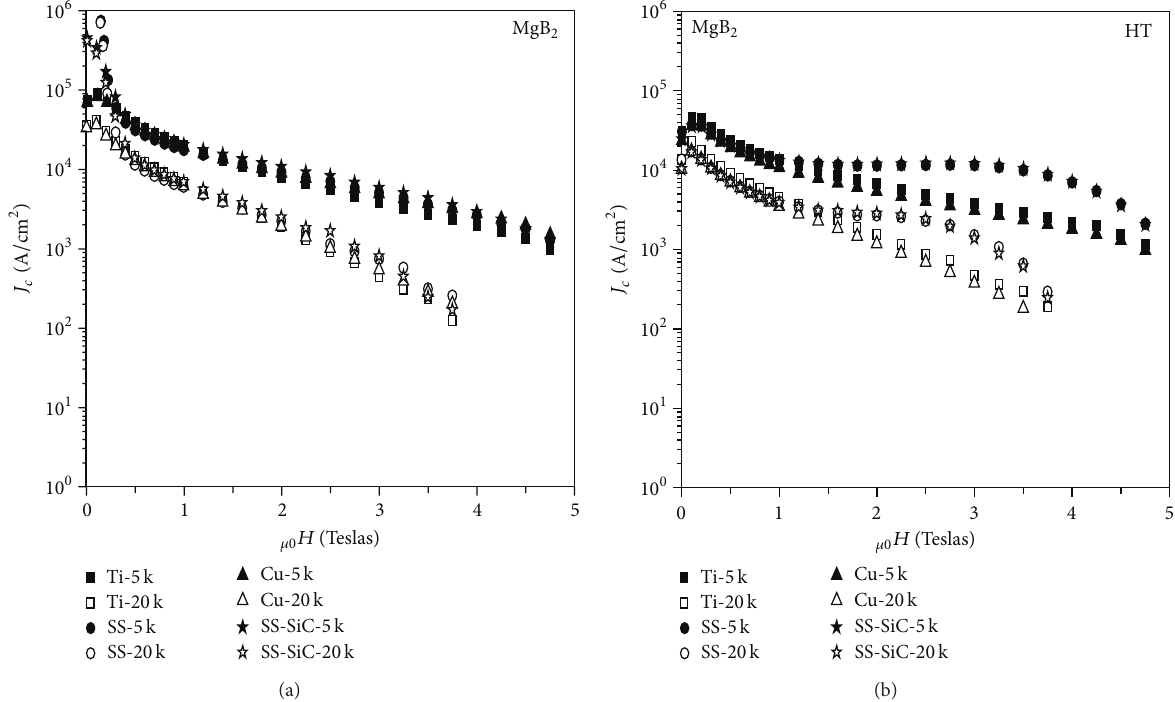
Figure 4: Magnetic 𝐽 𝑐 measurement of the MgB 2 superconducting wires: (a) Ti, Cu, SS, and SS-SiC before HT and (b) Ti, Cu, SS, and SS-SiC after HT.